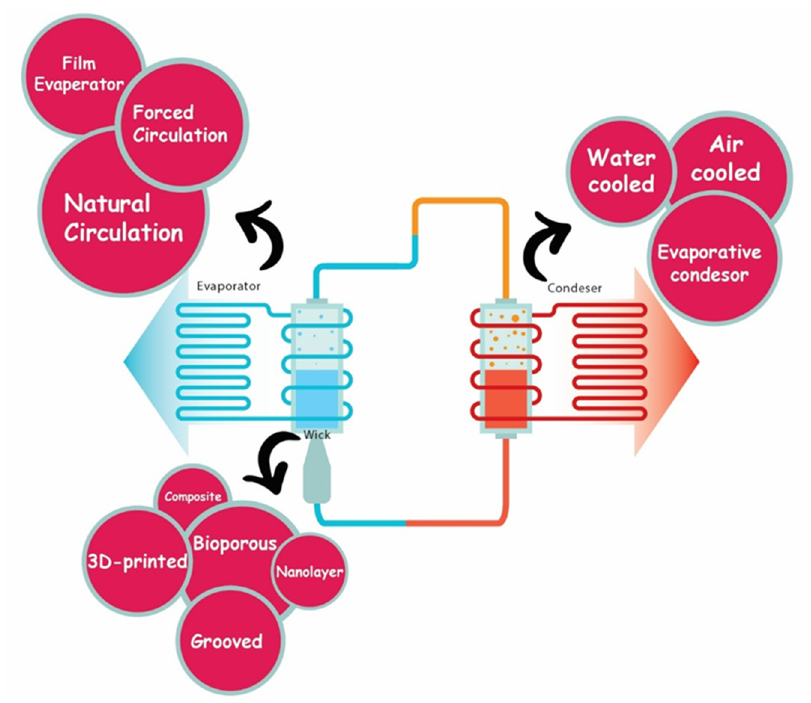
Figure 1. Categorization of different components of an LHP system based on wick structures, evaporators, and condenser.